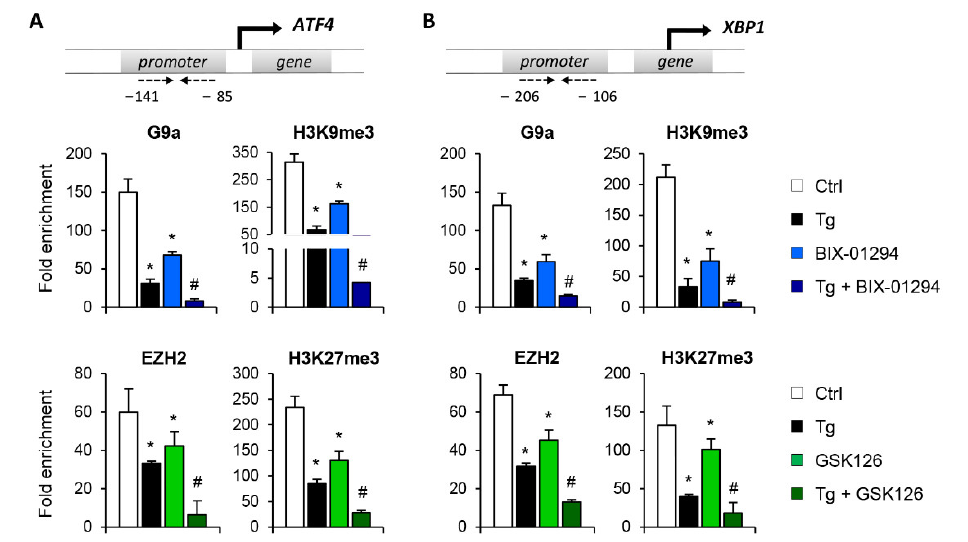
Figure 4. Treatment with BIX-01294 and GSK126 inhibits the direct binding of G9a and EZH2 to the ATF4 and XBP1 promoters, reducing the presence of repressive histone marks. HK-2 cells were treated with BIX-01294 (G9a inhibitor, 15 µ M, 24 h) or GSK126 (EZH2 inhibitor, 8 µ M, 24 h) in the absence or presence of thapsigargin (Tg, 4 µ M, 24 h). Cells treated with DMSO or Tg were used as negative and positive controls, respectively. ChIP assays were performed using specific antibodies against G9a, H3K9me3, EZH2 and H3K27me3, and normal rabbit IgG was used as a negative control. Enrichment of the DNA sequence associated with these HMTs and repressive marks in the promoter region of ATF4 ( A ) and XBP1 ( B ) genes were determined by quantitative RT-PCR using specific primers (dashed arrows). Data are shown as the mean ± SEM of three independent experiments and each RT-PCR was run in triplicate. Results are represented as the fold enrichment of each specific antibody relative to negative control (normal rabbit IgG). * p < 0.05 vs. control and # p < 0.05 vs. cells treated with BIX-01294 or GSK126.